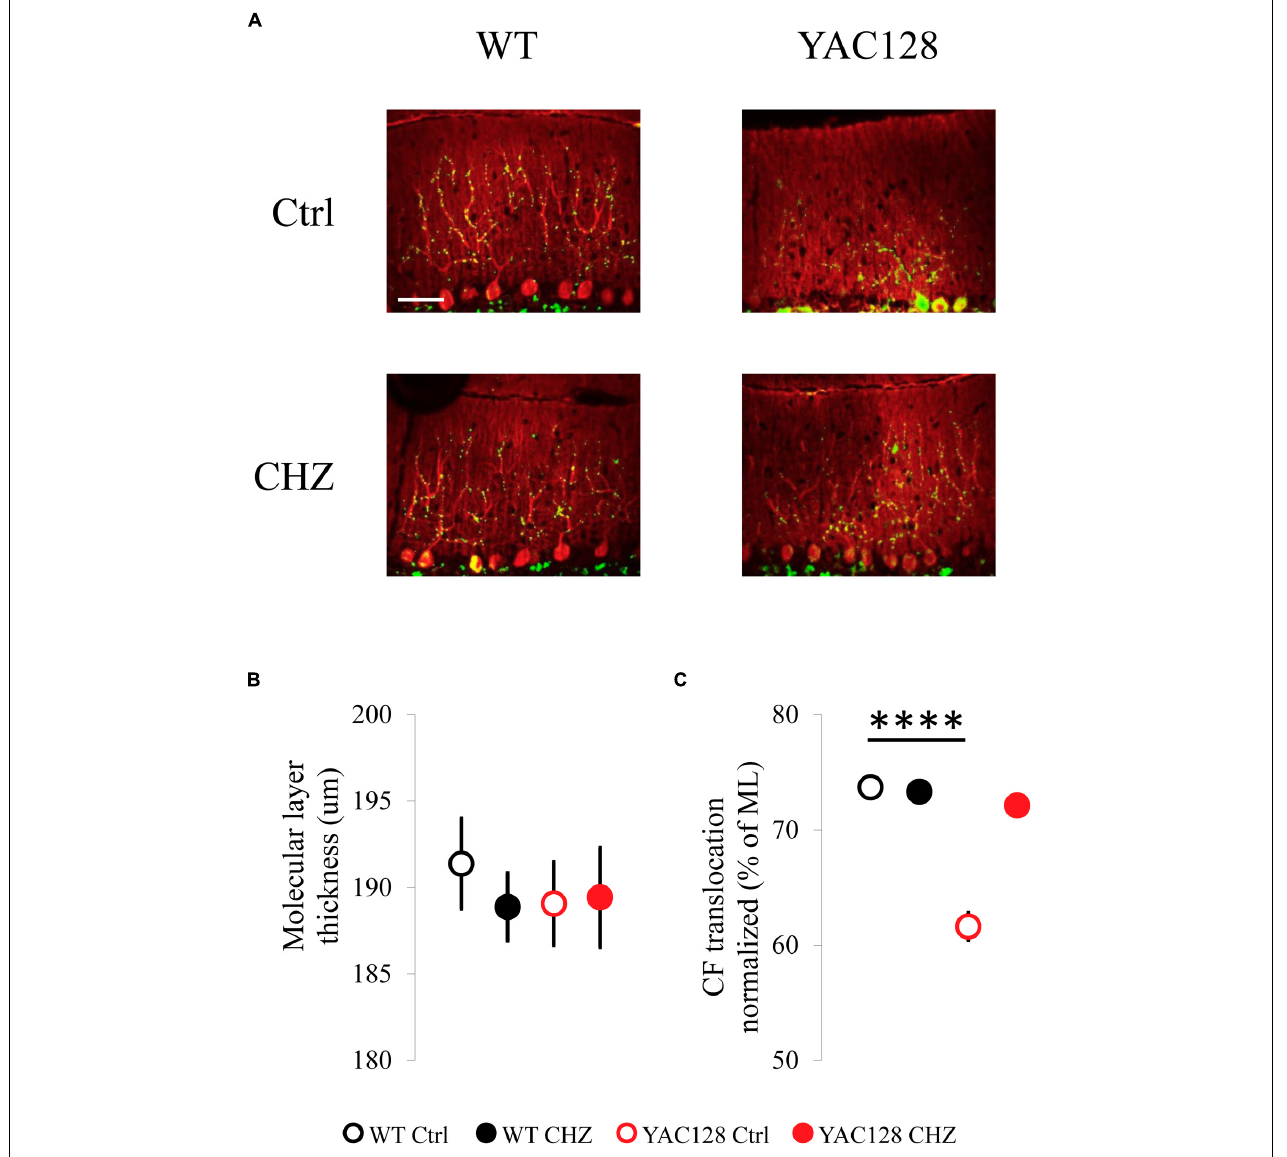
FIGURE 4 | Long-term injections of 30 mg/kg CHZ improved the CF terminal localization in 12-month-old YAC128 HD mice. (A) Immunofluorescently-labeled sagittal cerebellar sections show calbindin-positive PCs (red) and VGLUT2-positive CF terminals (green). Images were taken at 20X. Scale bar, 50 µ m. (B) Molecular layer thickness at the primary fissure was similar in WT and YAC128 mice in control and after the CHZ treatment. (C) CF terminal translocation measured as a percent of total molecular layer thickness was significantly less in YAC128 mice compared to WT mice and was recovered after long-term CHZ injections. **** p < 0.0001. For each experimental group number of animals m = 3, number of measurements n = 81. All results are shown as mean ± SE.